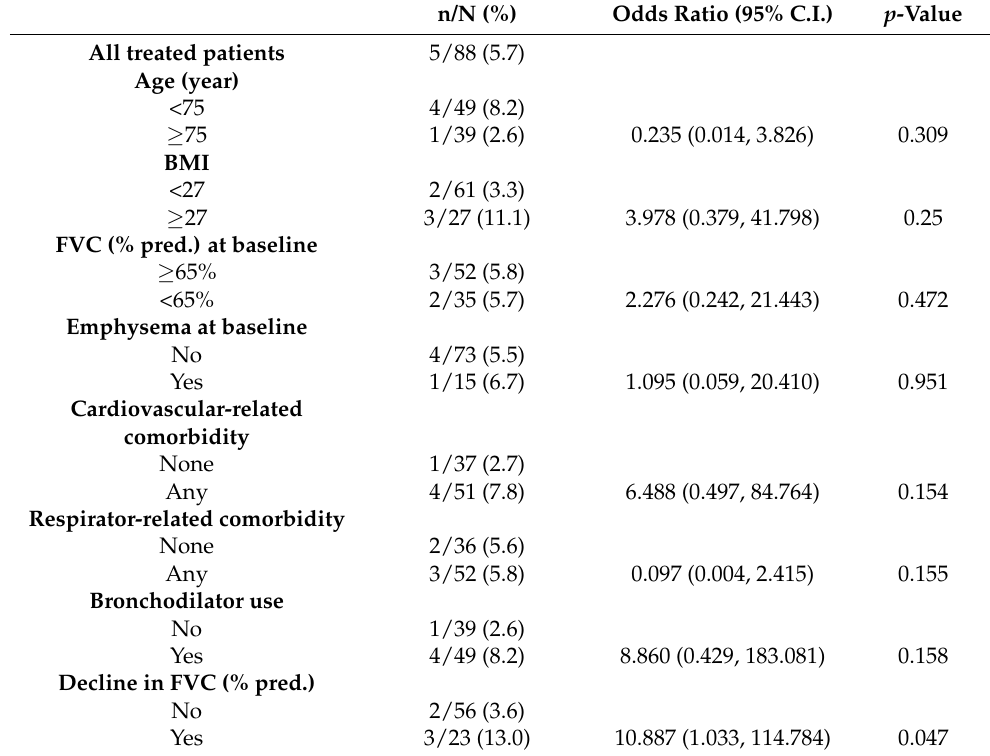
Table 5. Logistic regression analysis for acute exacerbation between weeks 53-104.